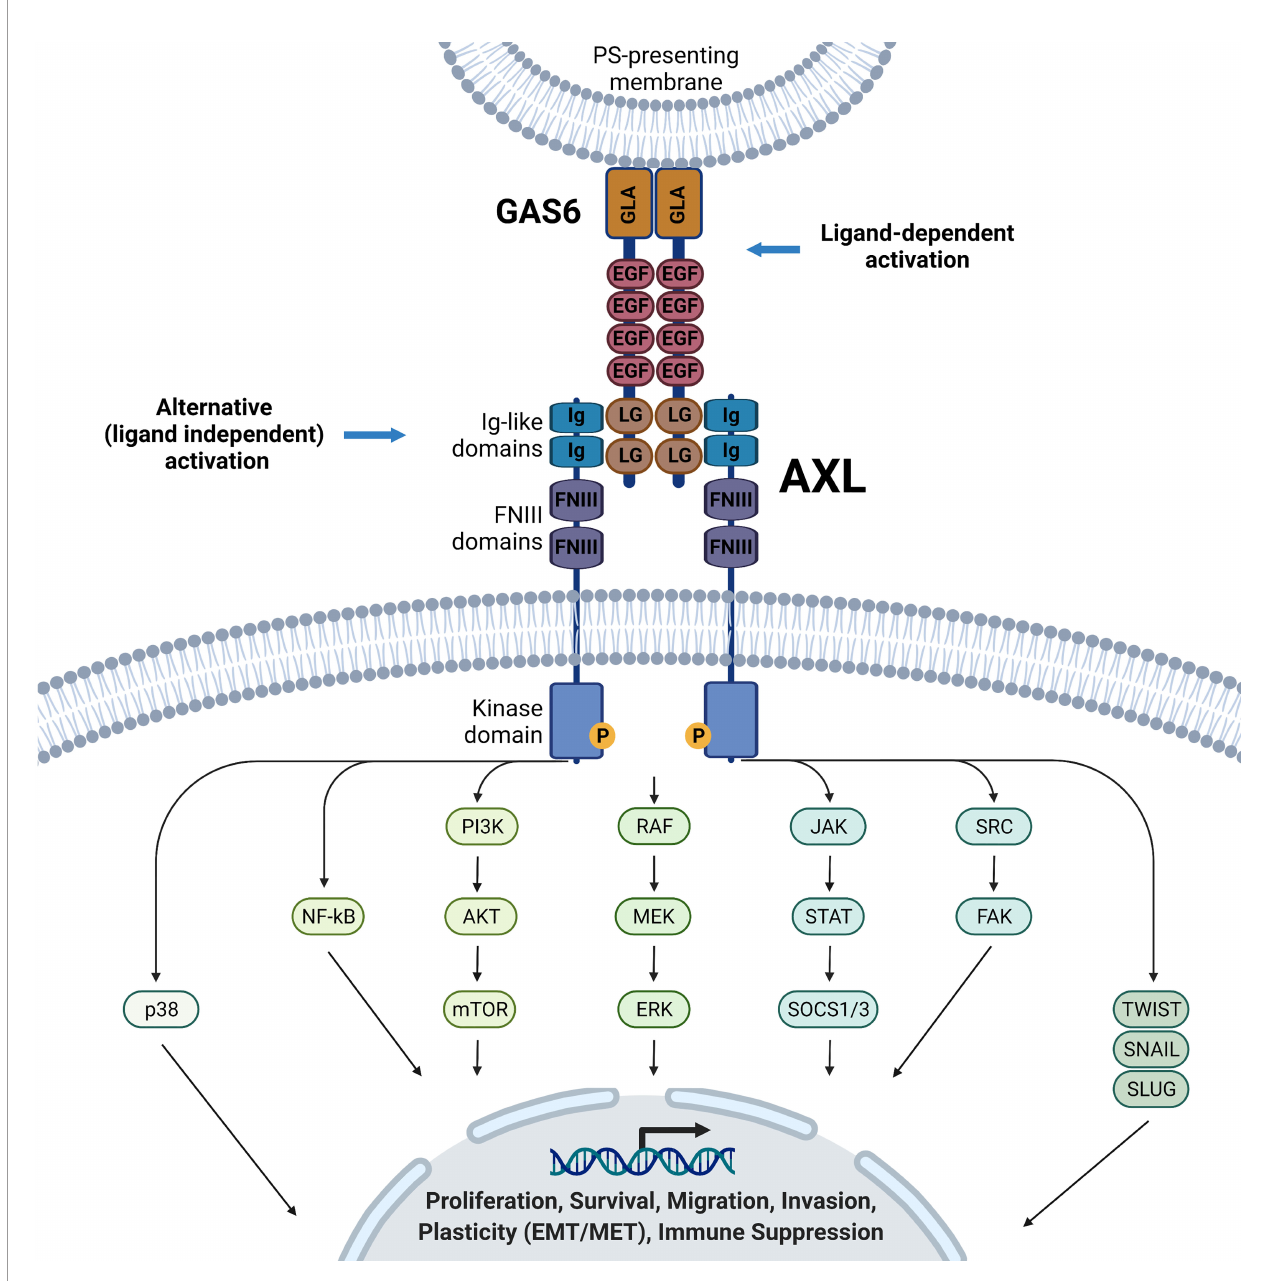
FIGURE 1 | GA6/AXL structure and downstream signaling pathways. Ligand binding of the AXL receptor tyrosine kinase promotes autophosphorylation and activates various downstream signaling pathways in a cell- and context-dependent matter, including, but not restricted to p38, NF-kB, PI3K/AKT/mTOR, RAF/MEK/ERK, JAK/ STAT/SOCS1/3, SRC/FAK, TWIST, SNAIL and SLUG signaling pathways. These pathways will lead to multiple phenotypes, including proliferation, survival, migration, plasticity, and immune suppression. Ligand-independent mechanisms of AXL activation have been proposed but are not detailed